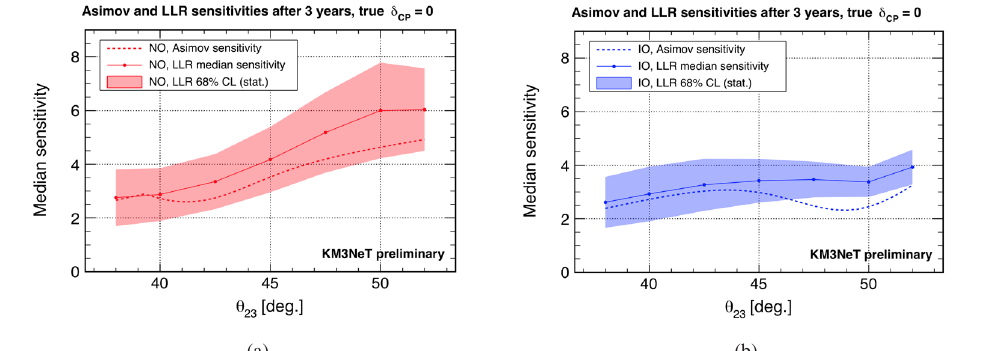
Table 1 . Oscillation and nuisance parameters, and Figure 1 . Signed χ 2 shown as a function of reconstructed neutrino energy and co-sine systematic uncertainties used for the NMO study. Figure 2 . Sensitivity of ORCA to the NMO after 3 years of data taking: (a) true Normal zenith for shower-like events. Figure in Ordering (NO) and (b) true Inverted Ordering (IO). Figures and more details on the statistical methods in Ref. [2].